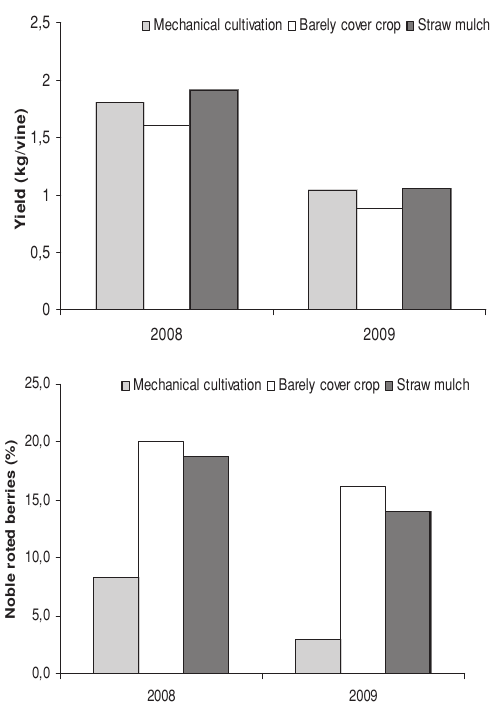
Figure 4. Yield and percent of noble rot between one bunch on plots treated by different soil cultivation methods in